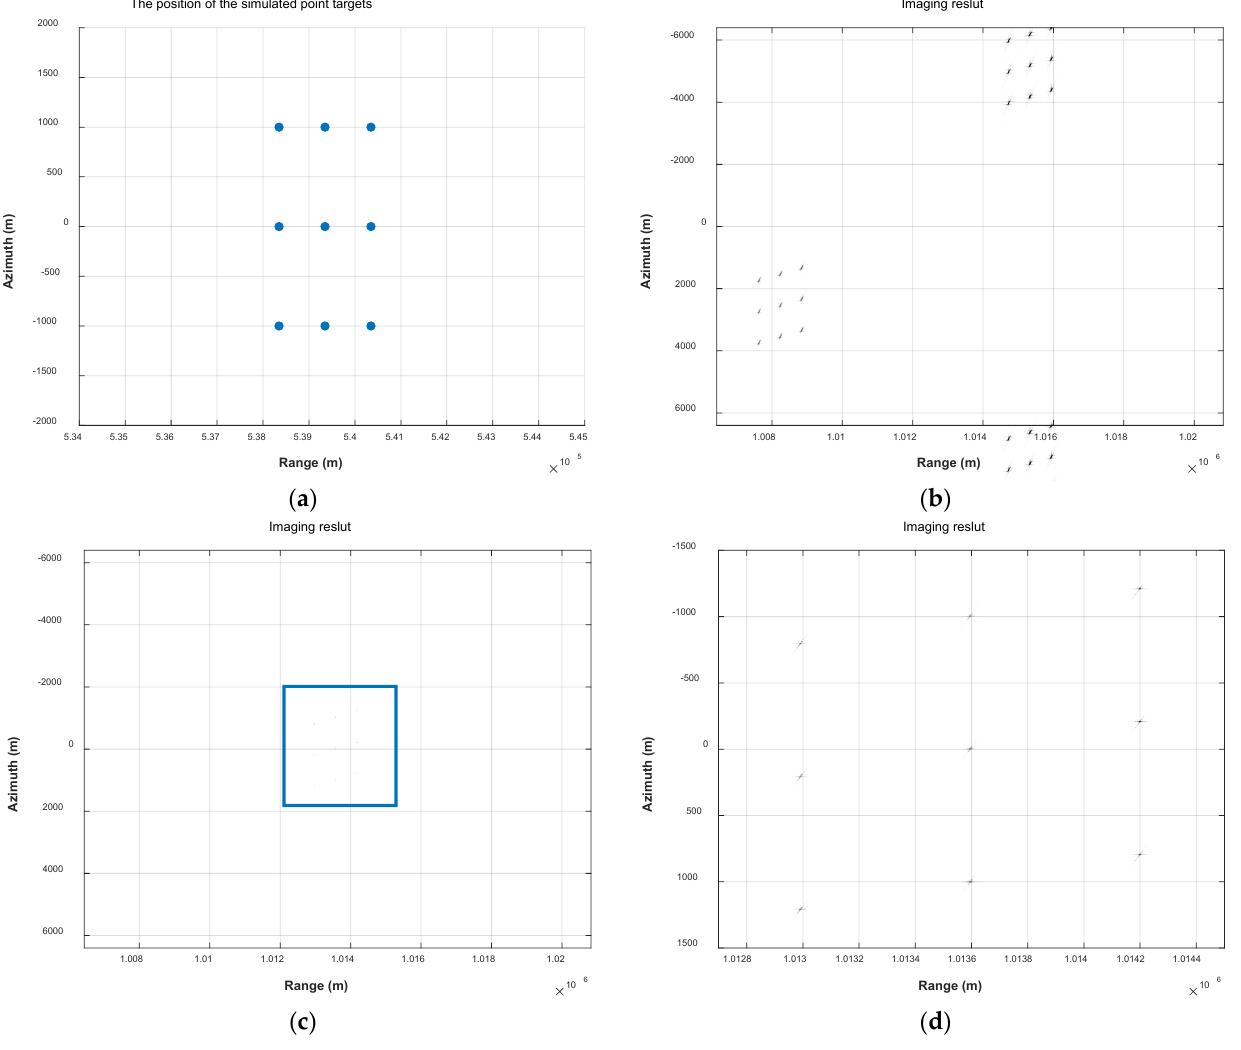
Figure 8. The simulation results imaging based on the ESRM and the MERM. ( a ) The position of the simulated point targets; ( b ) The imaging results based on the ESRM; ( c ) The imaging result based on the MESRM; ( d ) The enlarged view of the blue rectangle in the ( c ).